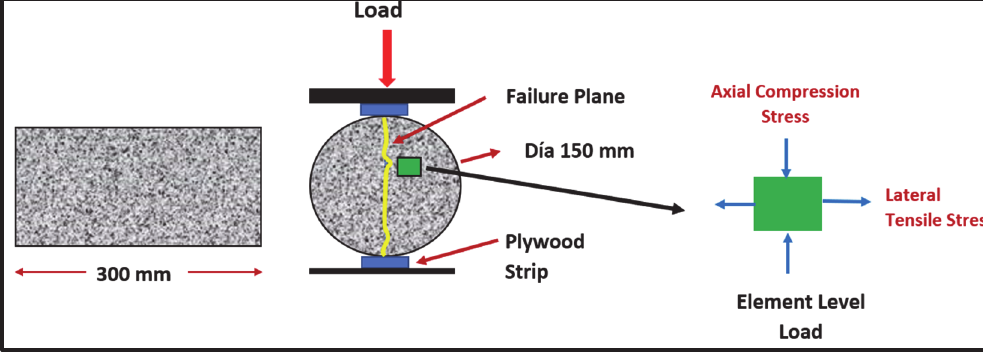
Figure 2: Schematic of sample dimension and compressive loading configuration.